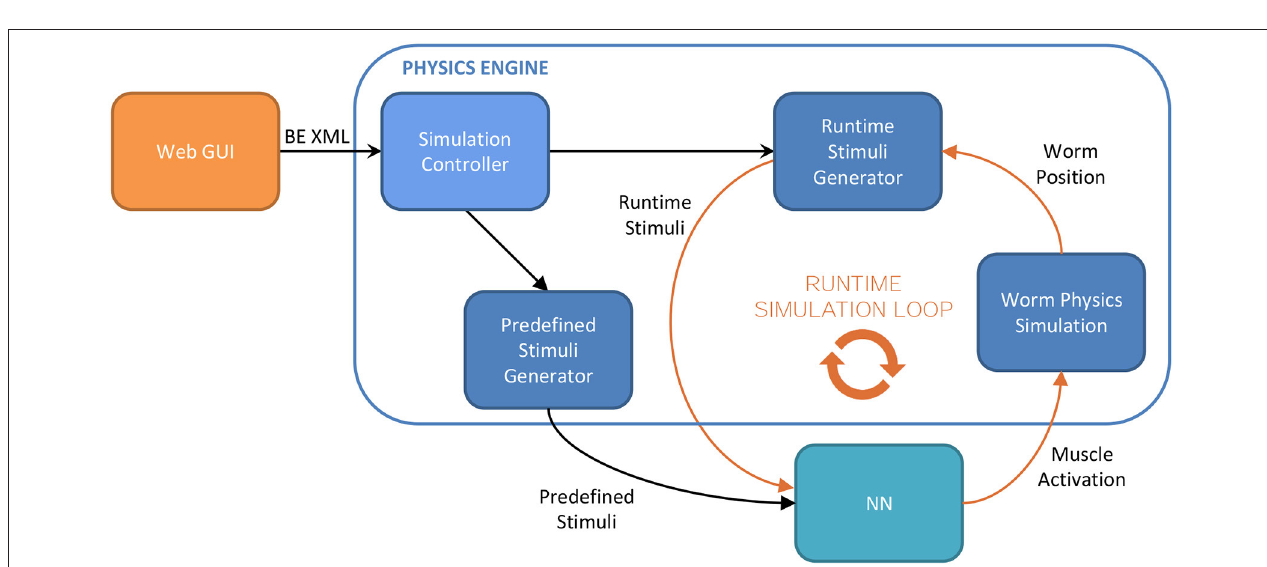
FIGURE 7 | Overview of the simulation workflow of the Si elegans platform, with depicted modules of the stimuli